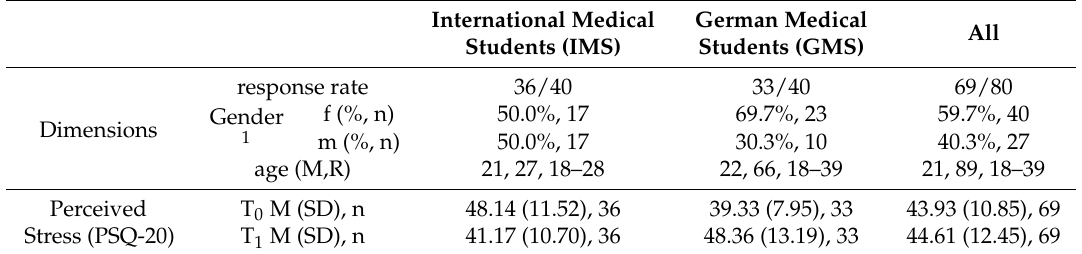
Table 1. Sample characteristics and descriptives of applied standard